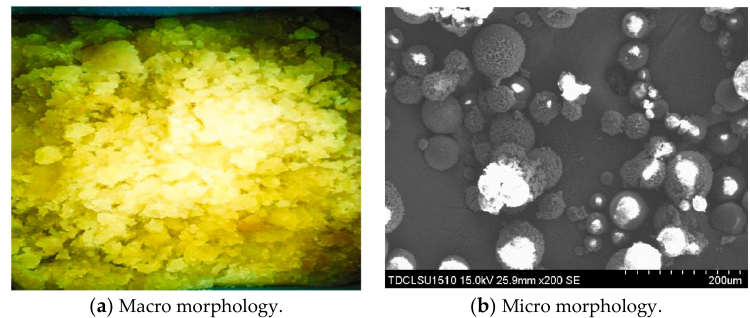
Figure 15. Exhibition of macro and micro morphology of PEG.